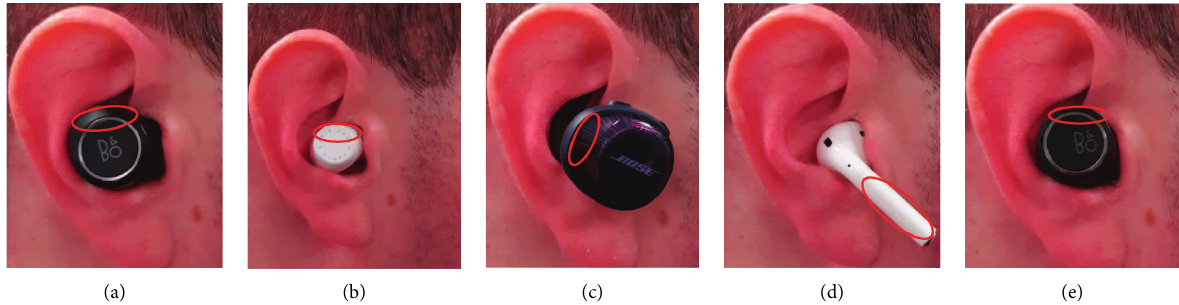
Figure 2: Positions of the earbud antennas marked with red ellipse: (a) Beoplay E8 2.0; (b) Earin M2; (c) Bose soundsport free; (d) Apple airpods 2; (e) Beoplay E8 3rd gen.